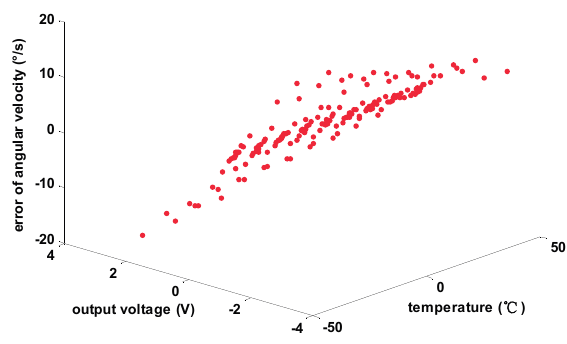
Figure 11. The angular velocity error of test points.